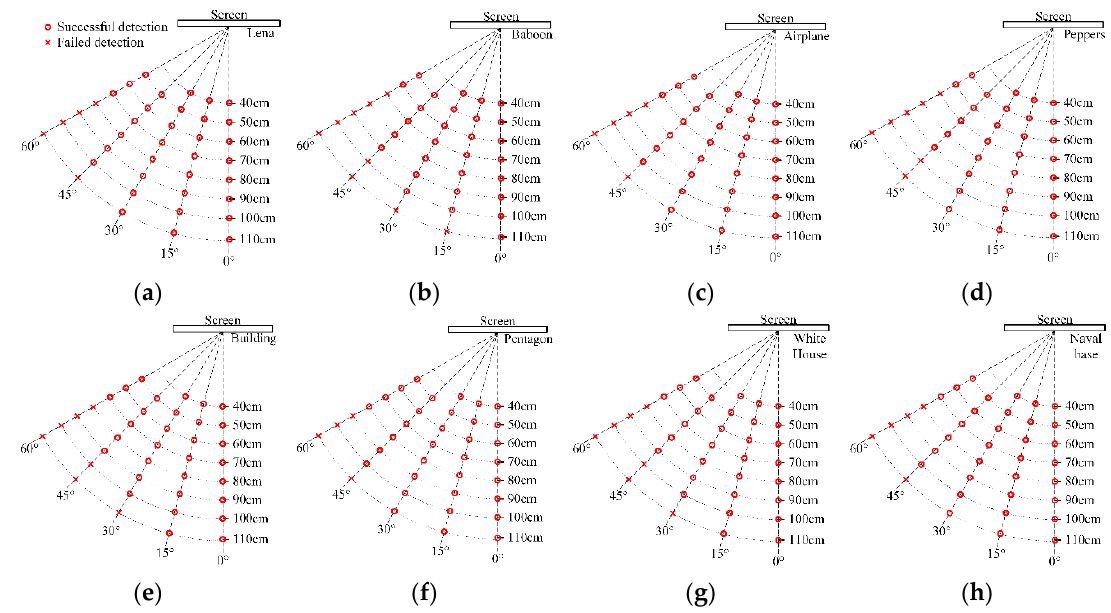
Figure 16. Watermark detection results against screen-cam attack. ( a ) Lena. ( b ) Baboon. ( c ) Airplane